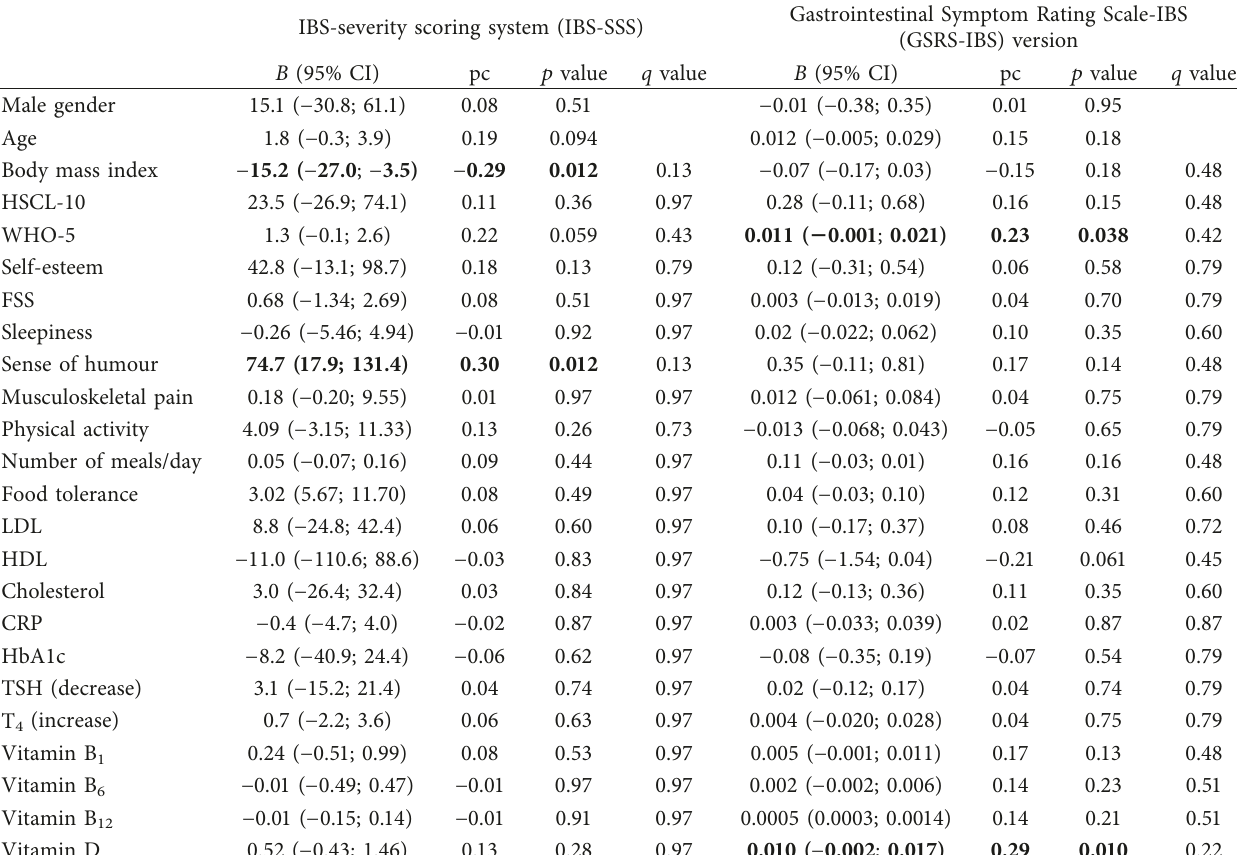
Table 6: Associations between the improvement in bowel symptoms and the improvement in the other